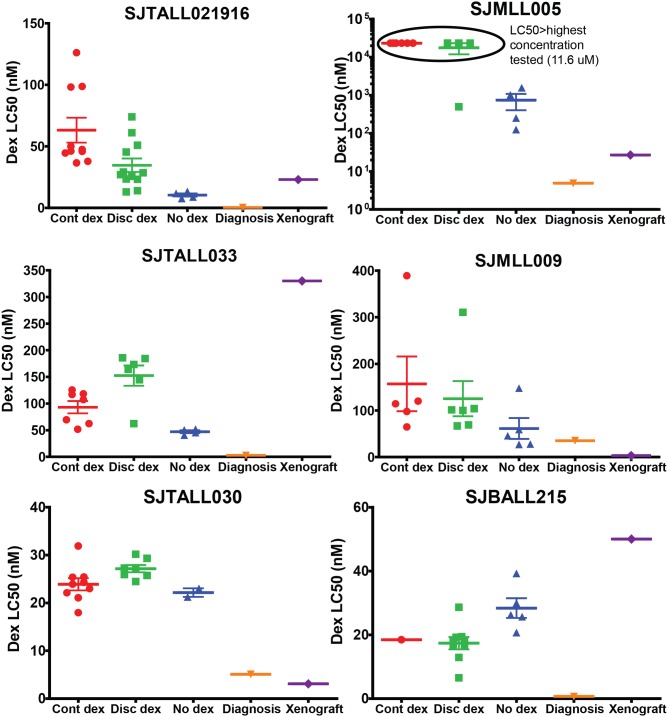
Leukemia cells generally became less sensitive to dexamethasone after in vivo treatment.Dexamethasone sensitivity of leukemic bone marrow cells at diagnosis (orange), the passage prior to in vivo treatment (purple), or at the time of sacrifice after in vivo treatment (continuous dexamethasone, red; discontinuous dexamethasone, green; no dexamethasone, blue). Symbols indicate individual mice, the horizontal line indicates the mean, and error bars indicate standard error of the mean (SEM). Incubation time for all diagnosis samples in the MTT assay was 4 days. Incubation time for cells from the mice receiving continuous dexamethasone, discontinuous dexamethasone, and no dexamethasone was 4 days for SJTALL021916, SJTALL033, SJBALL215, 3 days for SJTALL030, and 2 days for SJMLL005 and SJMLL009. Ex vivo sensitivity was not tested in SJE2A007 due to poor viability after two days ex vivo (<50%), and SJHYPO123 due to resistance of the sample at the time of diagnosis (LC50 > highest concentration tested, 15 uM, which was recapitulated in the xenograft sample prior to in vivo treatment).